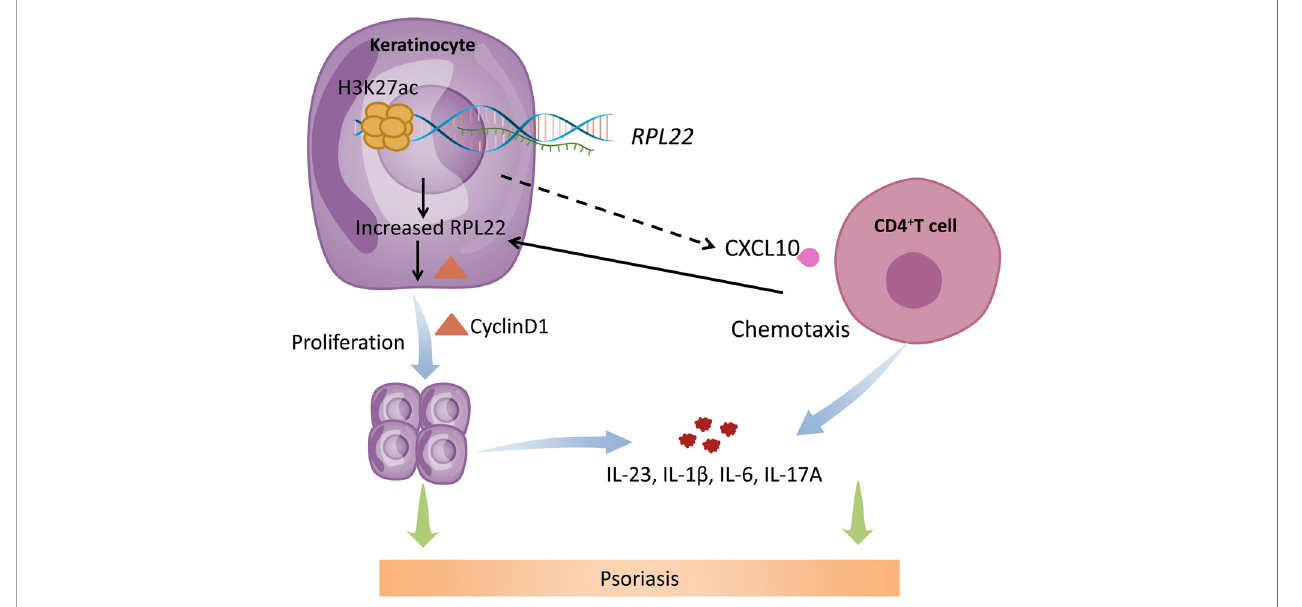
FIGURE 8 | Schematic illustration of RPL22 contributing to the pathogenesis of psoriasis. In psoriasis patients, hyperacetylation of histone H3K27 in the promoter region of RPL22 in the skin lesions of psoriasis patients induces RPL22 overexpression, overexpressed RPL22 up-regulates CyclinD1 expression to promote the KCs proliferation and enhancing CXCL10 expression to induce CD4 + T cells chemotaxis, Both of them secrete cytokines including IL-23, IL-6, IL-1 b and IL-17a to aggravate the occurrence and development of